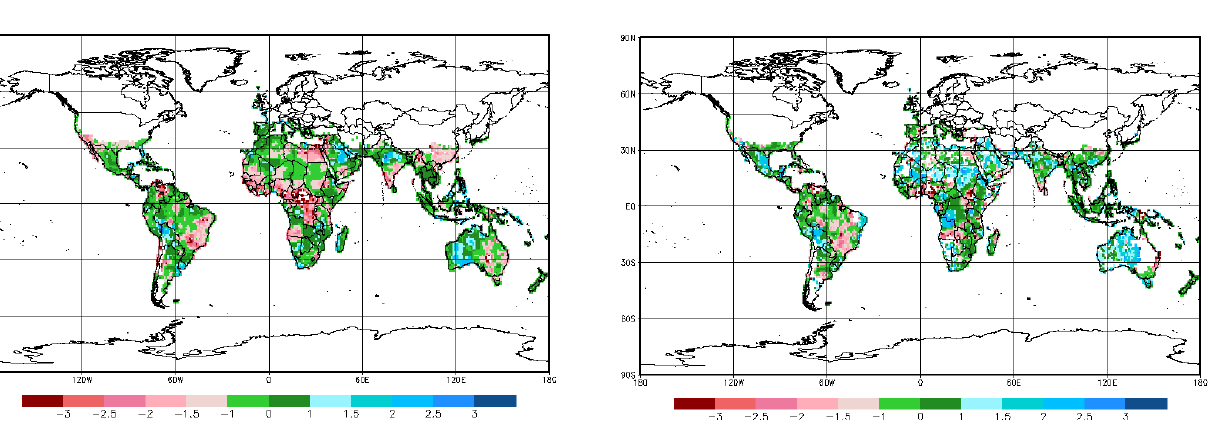
Figure 6. PET calculated according to Thornthwaite (1948) for Jan- uary 2014.